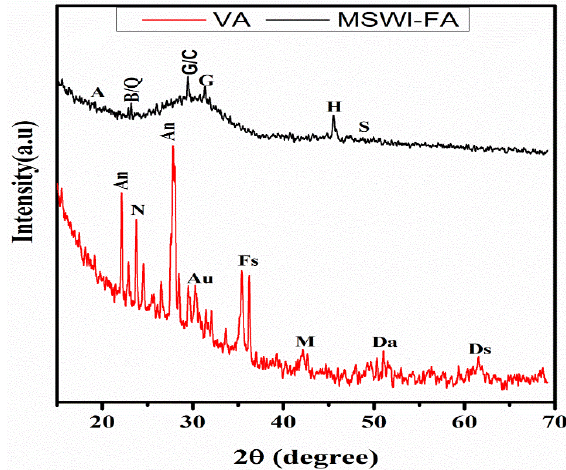
Figure 1. X-ray diffractogram of MSWI-FA and VA (A = Anhydrite, B = Bassanite, G = Gypsium, S = Sylvite, C = Calcite, Q = Quartz, H = Halite, An = Anorthite, F = Feldspar-Na, N = Nepheline, M = Maghemite, F = Forsterite, A = Augite, Ds = Diopside Sodian, Da = Diopside Alumina).